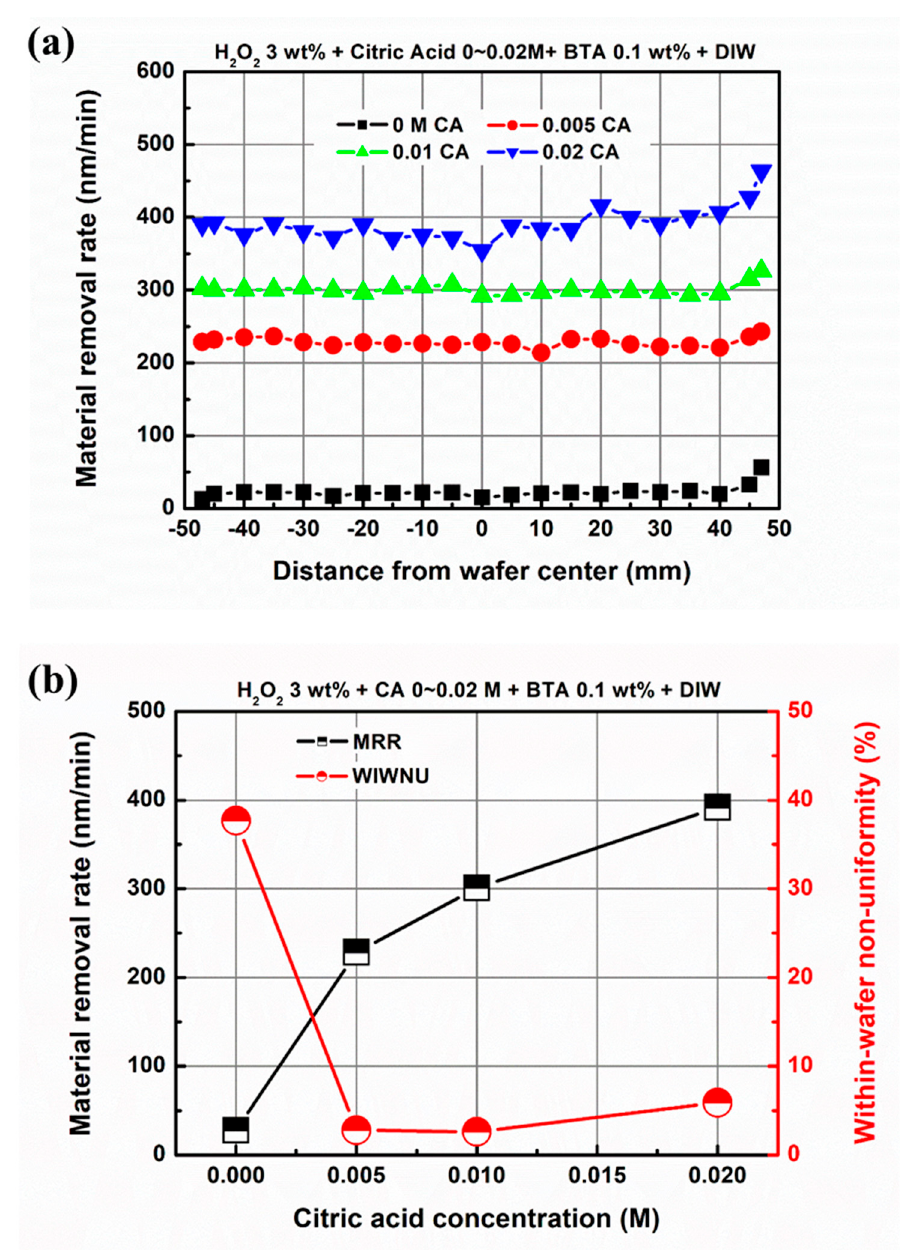
Figure 10. CMP results as a function of citric acid concentration; ( a ) MRR distribution and ( b ) average MRR and WIWNU.